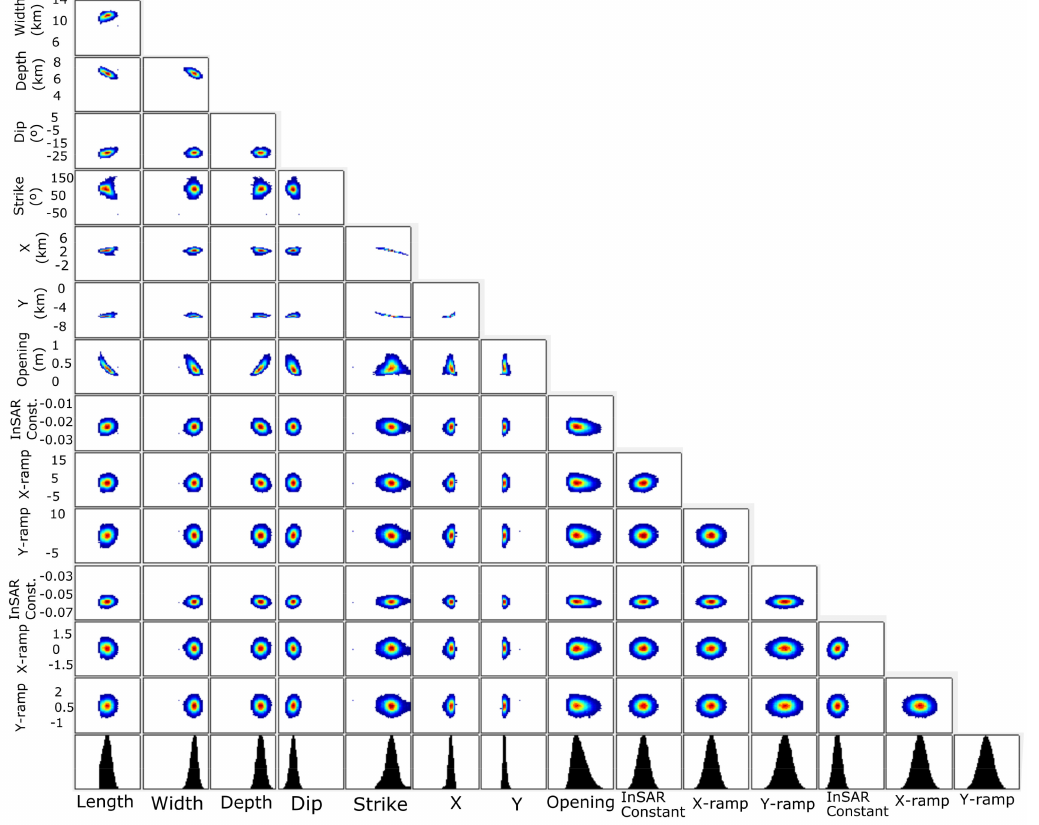
Figure 8. Joint probabilities for the modeling of InSAR data with a rectangular dipping